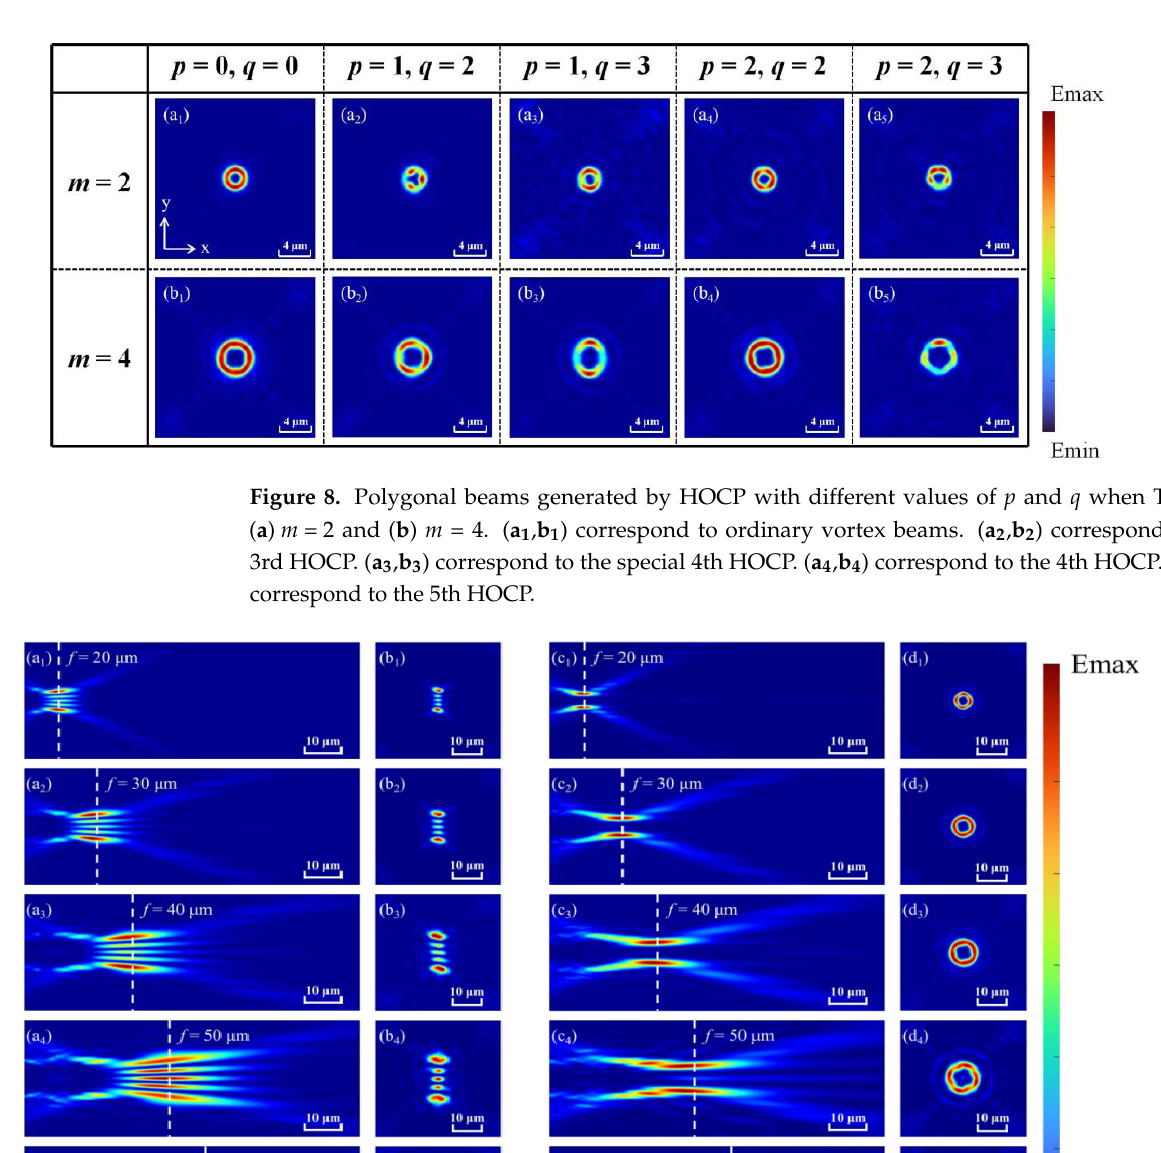
Figure 10. The influence of different u values on LOCP and HOCP. ( a ) LOCP light field distribution. ( b ) LOCP phase distribution. ( c ) HOCP light field distribution. ( d ) HOCP phase distribution.